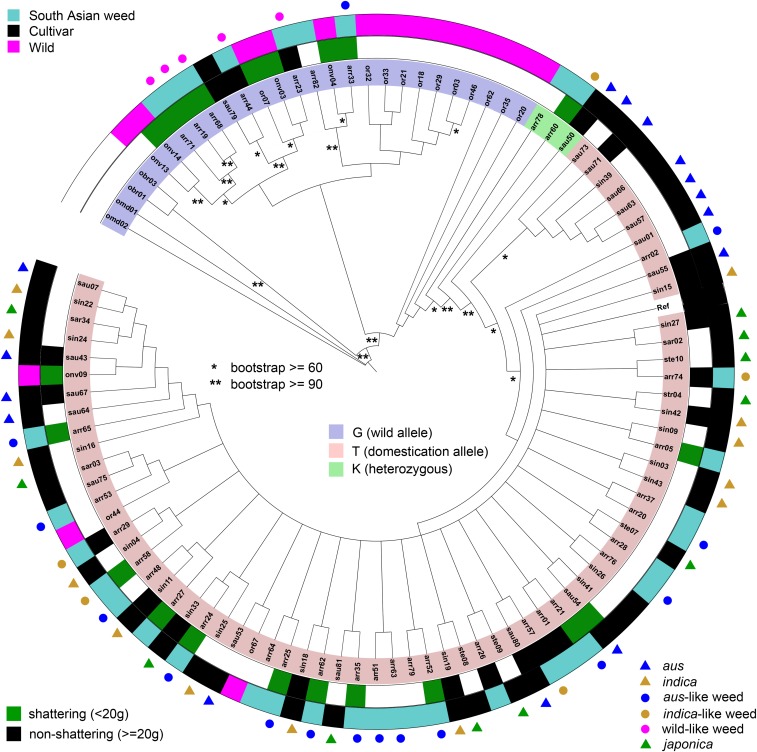
Neighbor joining (NJ) tree of Sh4 haplotypes. The color range indicates the allele of the functional SNP; the inner ring indicates the shattering phenotype. The outer ring and the bullets indicate Oryza groups, as labeled in the key. Unmarked weeds are admixed according to results of Huang et al. (2017). Asterisks on branches indicate bootstrap values as labeled.